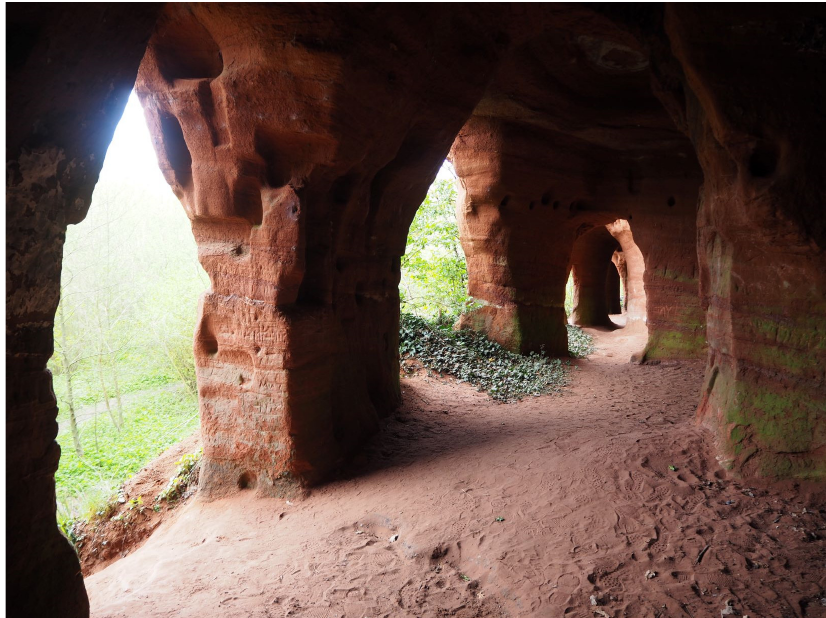
Figure 4. Redstone Rock Hermitage. Redstone Rock Hermitage, Worcestershire, is a massive complex of caves comprising at least 10 main rooms and with a known later medieval history and features that suggest an early medieval origin. Photograph E.R Simons.